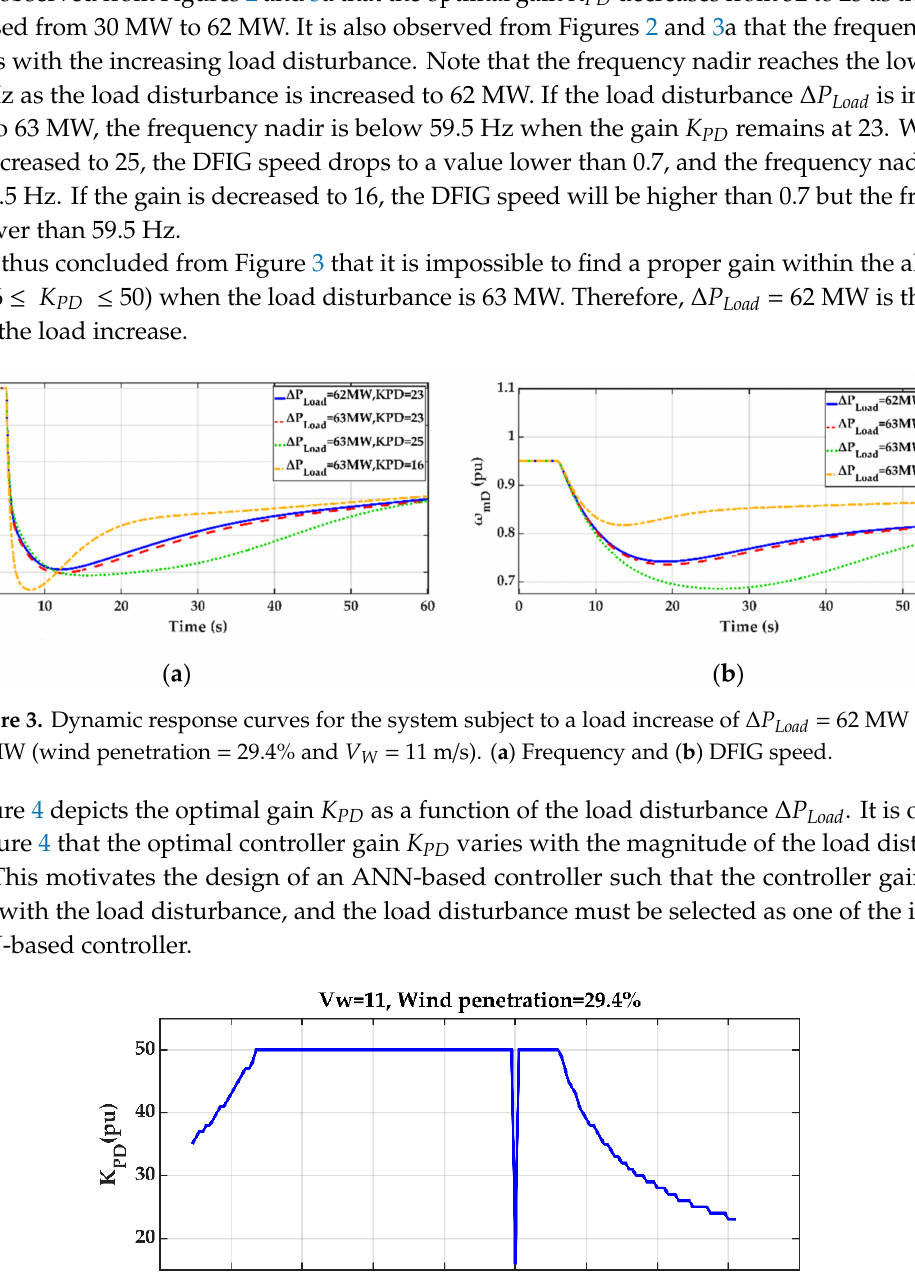
Figure 2. Dynamic response curves for a load disturbance of ∆ P Load = 30 MW (wind penetration = 29.4% and V W = 11 m/s). ( a ) Frequency, ( b ) DFIG speed, ( c ) DFIG electrical power, and ( d ) SG mechanical power. K PD : the optimal gain.